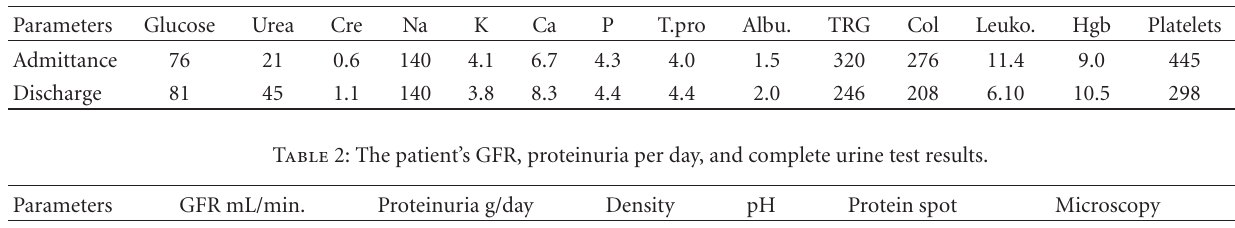
Table 1: The patient’s admittance and discharge biochemistry and complete blood values.